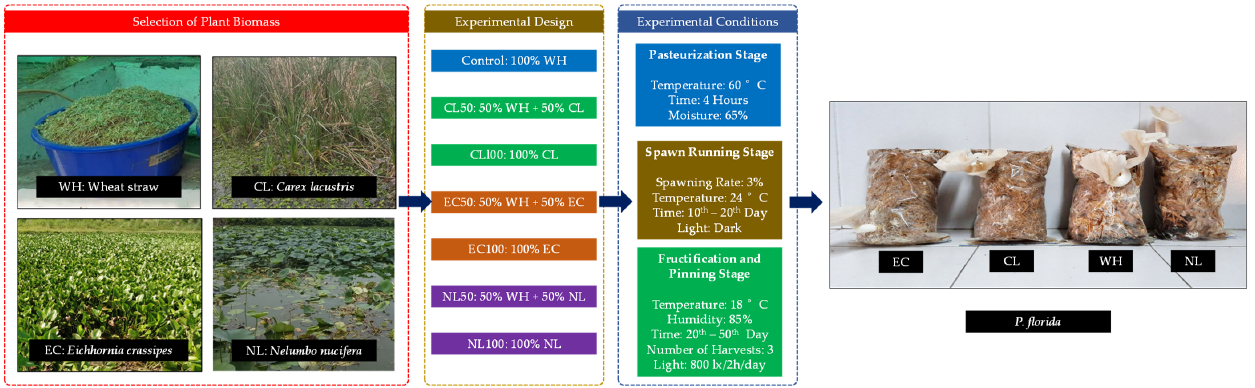
Figure 1. Study layout for plant biomass selection, experimental design, and conditions for cultivating P. florida .